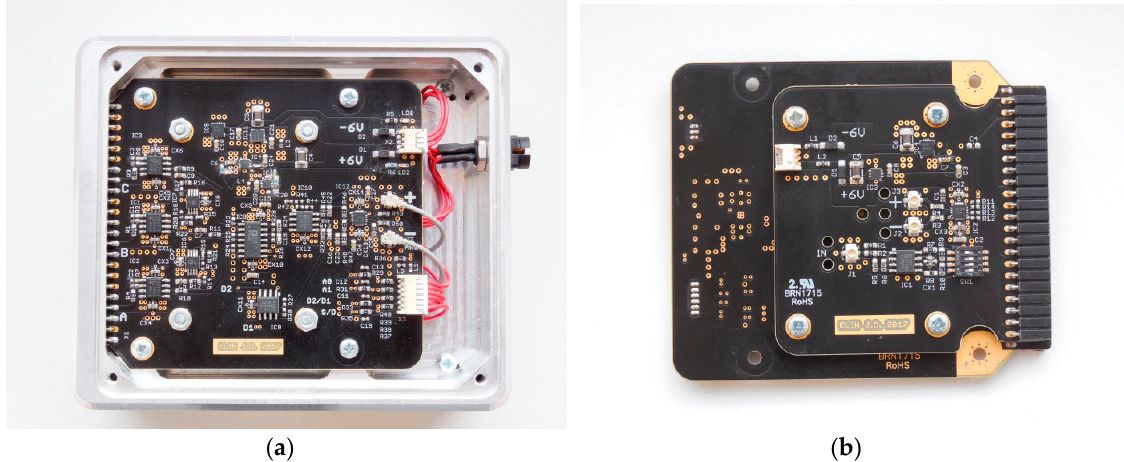
Figure A2. A photograph of the response chain’s module of the front-end ( a ) (top cover of the analyzer is removed) and the excitation module ( b ) of the front-end, fixed underneath of the same response chain module. Note: the power supply switch shown in Figure 6 is not implemented here.